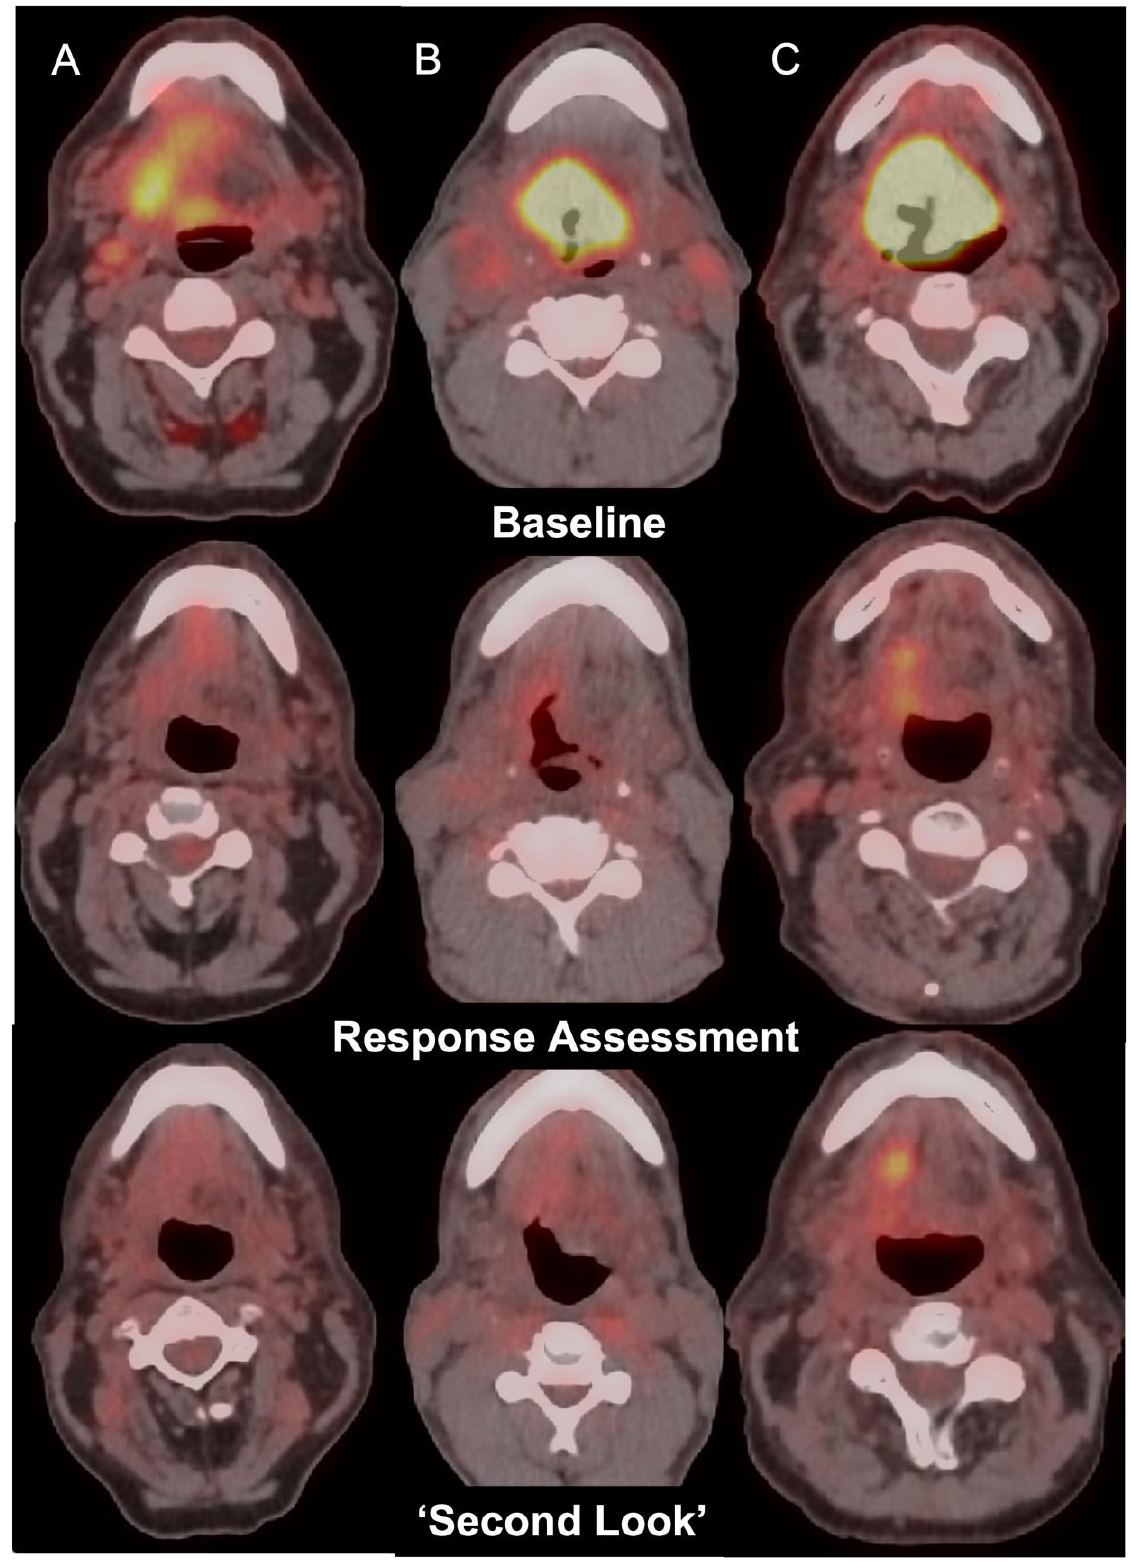
Figure 1. Axial fused FDG PET-CT images in 3 patients with oropharyngeal carcinoma (Top row, Columns A, B, C) with incomplete response at the primary tumour site on post-treatment FDG PET-CT (middle row) showing negative ( A ), equivocal ( B ), or positive ( C ) changes on ‘second-look’ imaging (bottom